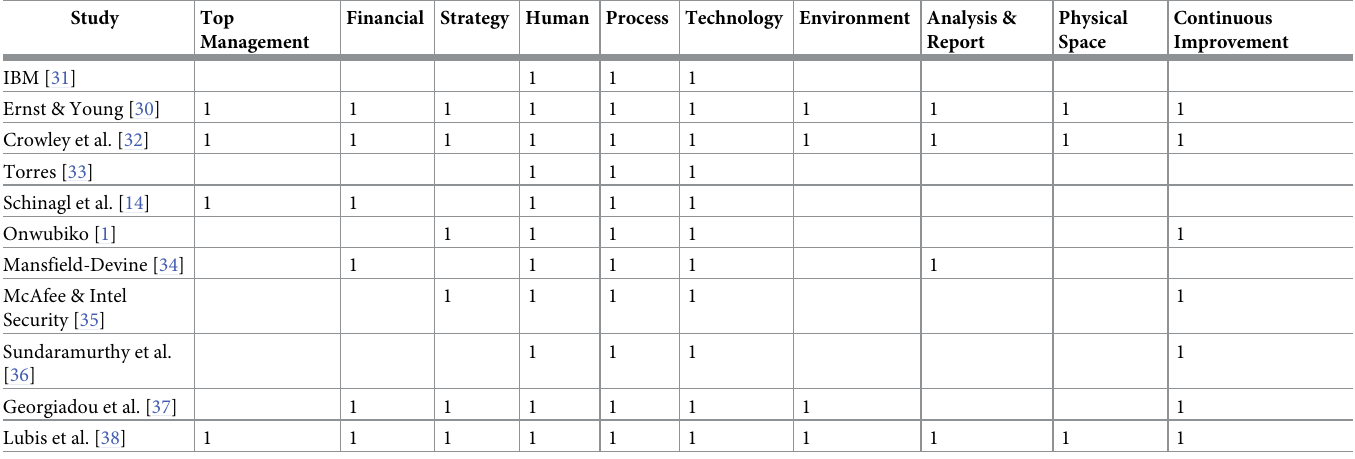
Table 1. Success factors for